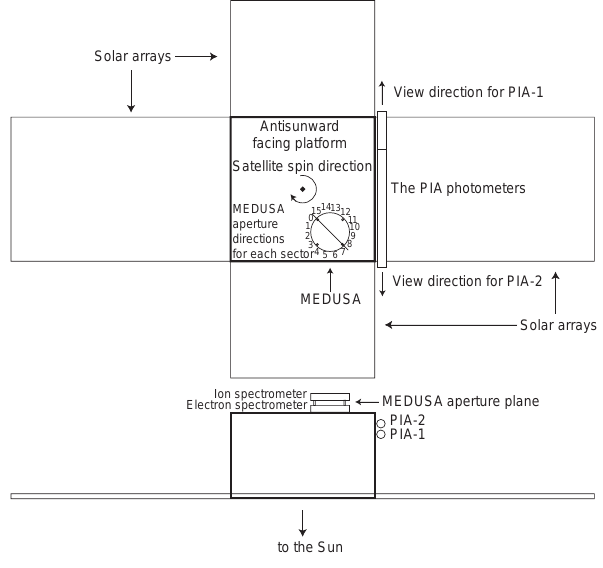
Fig. 2a. The view directions of the MEDUSA and PIA instruments.